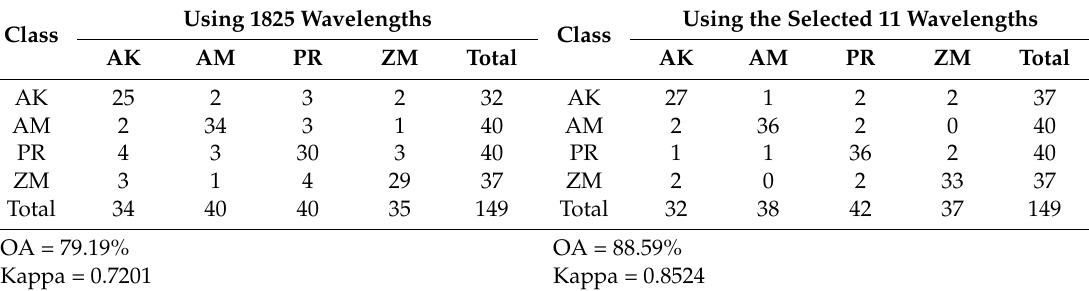
Table 2. Confusion matrix showing the overall classification and Kappa for discrimination among the four vegetation species; Prosopis glandulosa (PR), Acacia karroo (AK), Acacia mellifera (AM) and Ziziphus mucronata (ZM). The error was calculated using the out-of-bag (OOB) method and the test dataset.